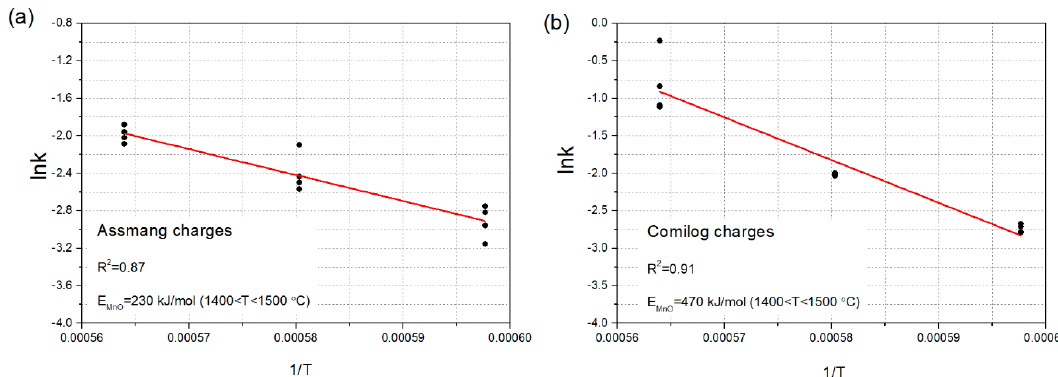
Figure 5. Arrhenius plot calculated from reaction rates of reduction for ( a ) Assmang charges; ( b ) Comilog charges from Equation (8).